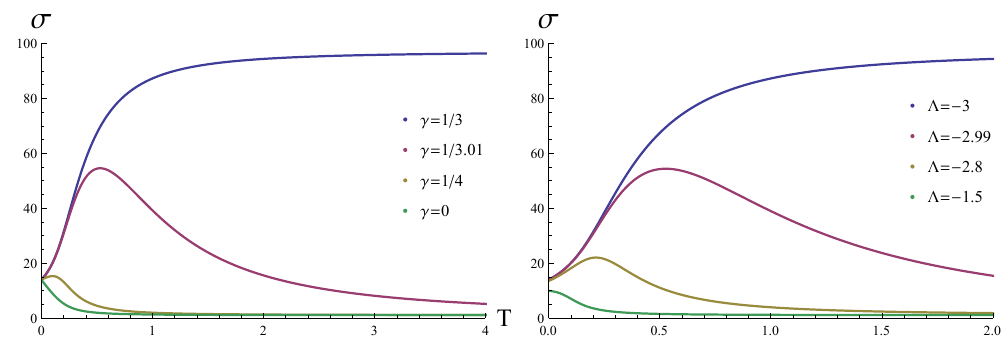
Figure 1 . Plots of the conductivity (cid:27) versus temperature, for various parameter choices. In each diagram we have set (cid:20) = (cid:11) = q = 1 and (cid:21) = 1 = 2. In the left-hand diagram we (cid:12)x (cid:3) = (cid:0) 3 and take various choices for the parameter (cid:13) . The top line has the critical value (cid:13) = 1 = 3, for which ( (cid:11) + (cid:13) (cid:3)) = 0. In the right-hand diagram we instead (cid:12)x (cid:13) = 1 = 3 and take various choices for